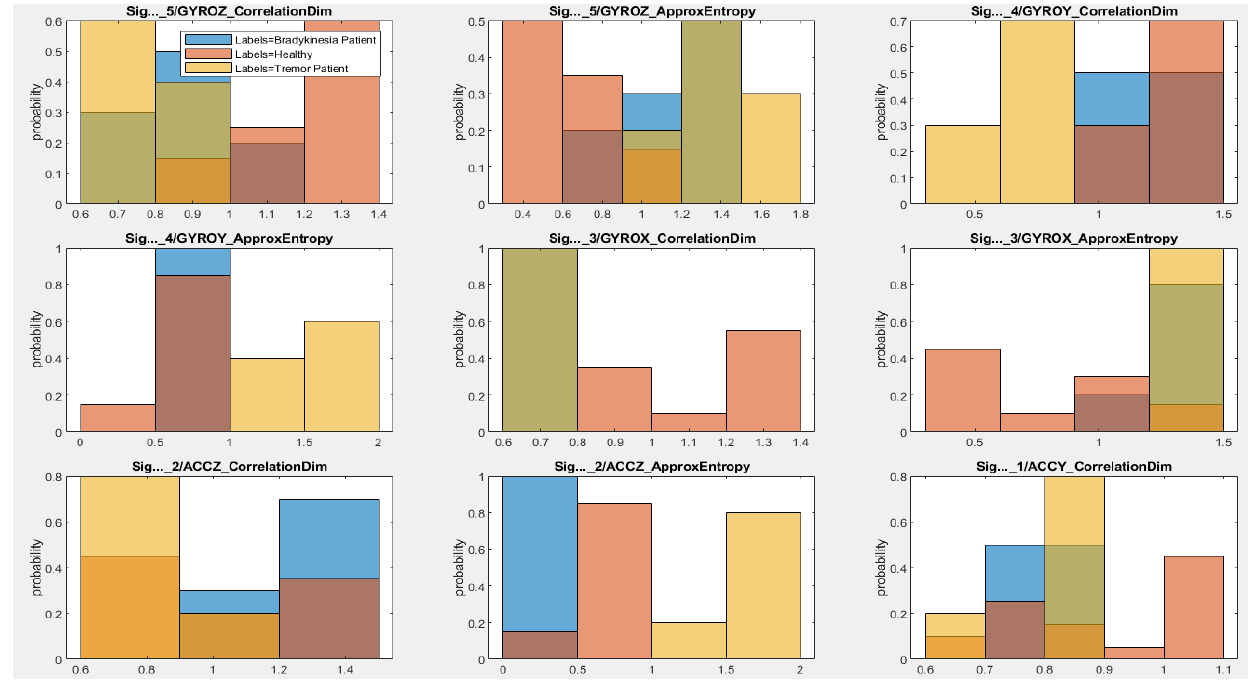
Figure 7. Visualization of PD patient signals before and after filtering in time and frequency domain. The effectiveness of the extracted features is evaluated using histograms, as shown in Figure 8. These histograms of each feature type show the correct distribution of features with respect to class type. On these plots, a different color indicates a different class type. Because of overlapping distribution of different class types and the high dimensionality of features, it is difficult to decide which features are more relevant and separable.